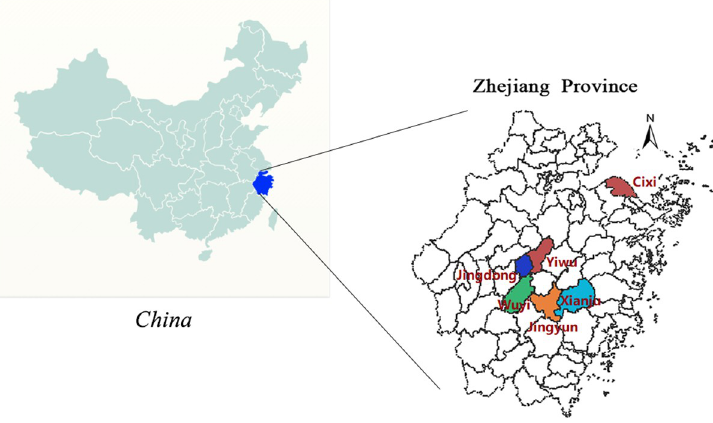
Fig 1. Sites of mosquito surveillance in Zhejiang Province, China, 2015–2018. Map was created by R version